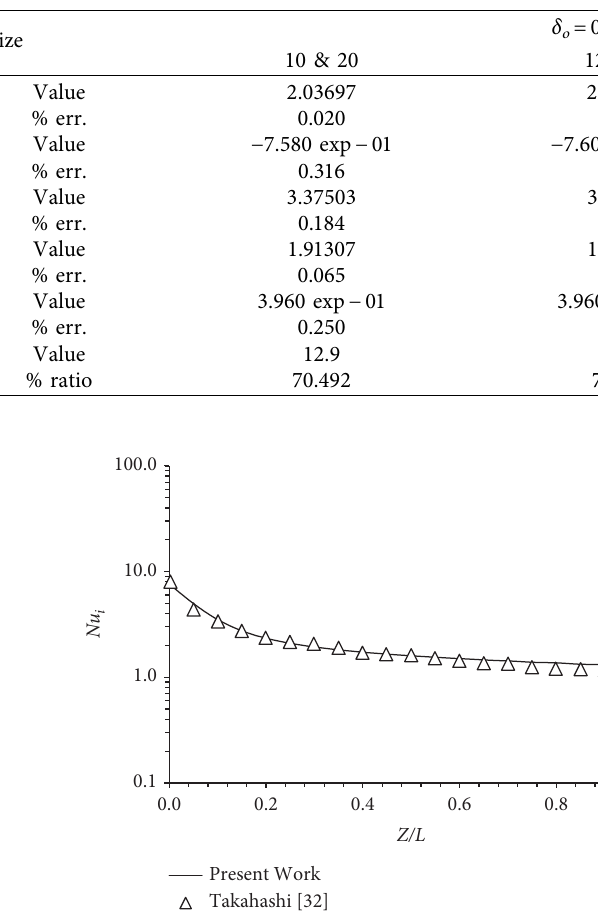
Table 2: Two mesh combinations in R -direction of outer and inner cylinder walls.